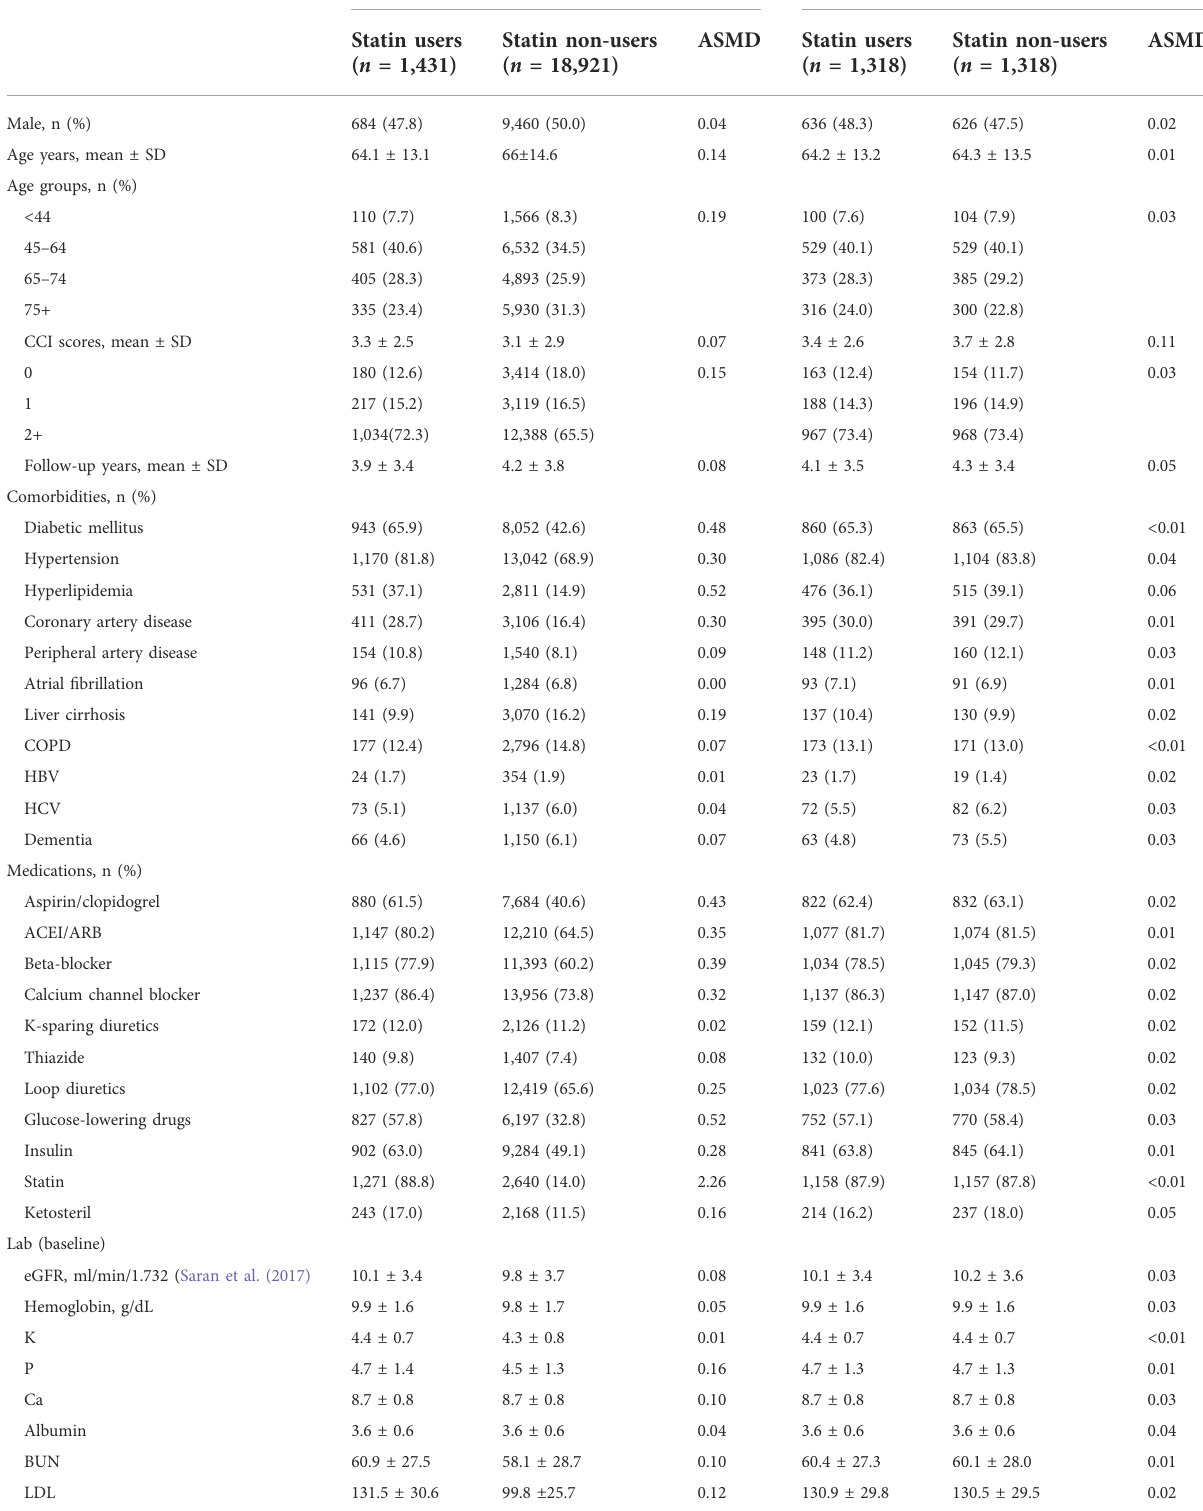
TABLE 1 Demographic characteristics of study population before and after propensity score matching.